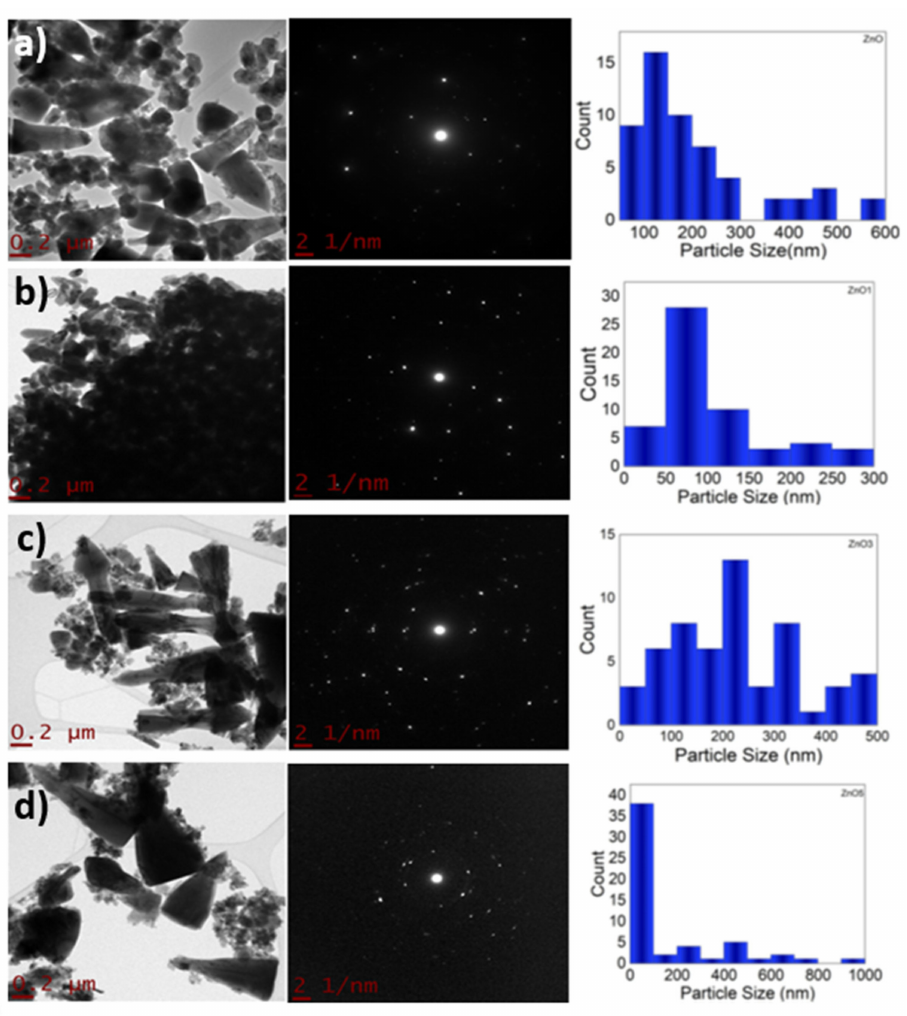
Figure 2. Transmission electron microscopy of Zn-Ca nanocomposites. ( a ) ZnO, ( b ) Zn-Ca 1, ( c ) Zn-Ca 3, ( d ) Zn-Ca